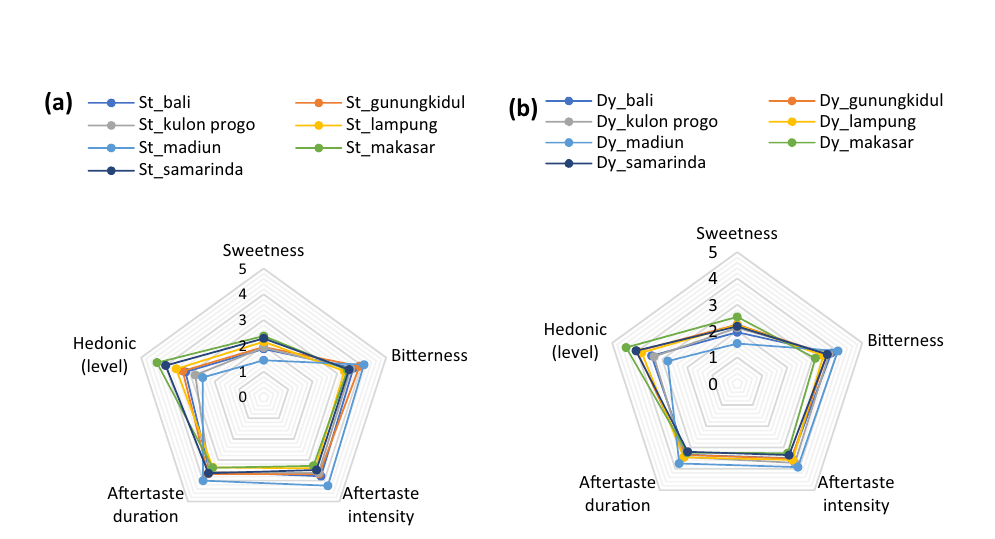
Figure 1: Sensory pro fi le of single - origin chocolate made of cocoa beans from seven regions in Indonesia: ( a ) Chocolate processed using the static roasting ( St ) . ( b ) Chocolate processed using the dynamic roasting ( Dy )